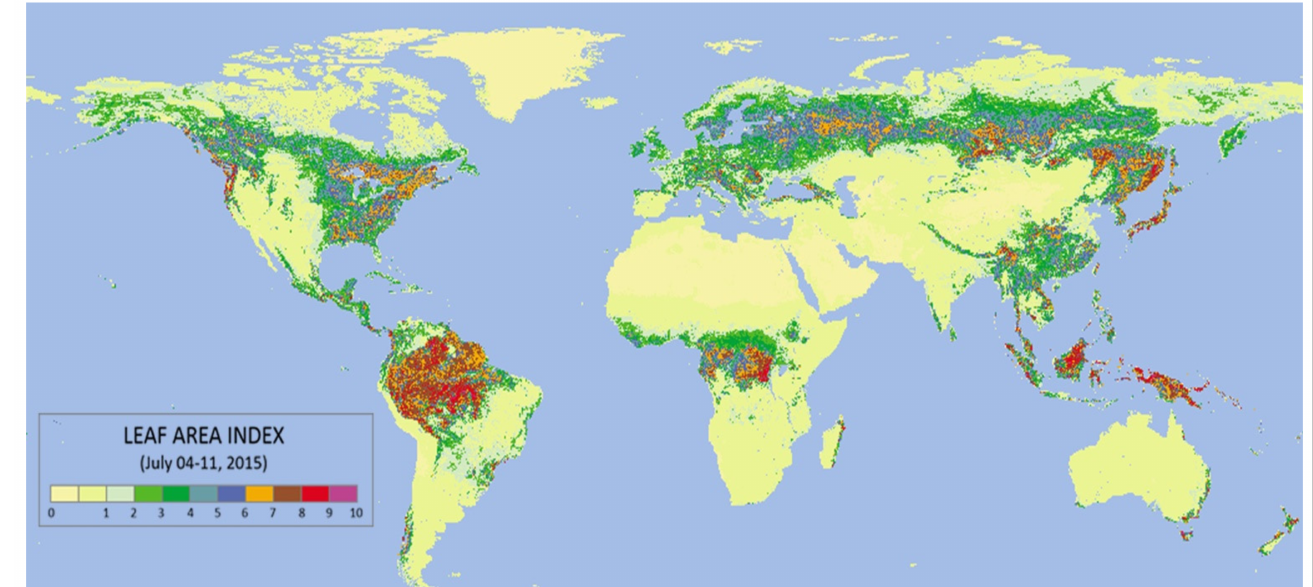
Figure 3. A global LAI map on 4–11 July 2015 at 8 km resolution is an